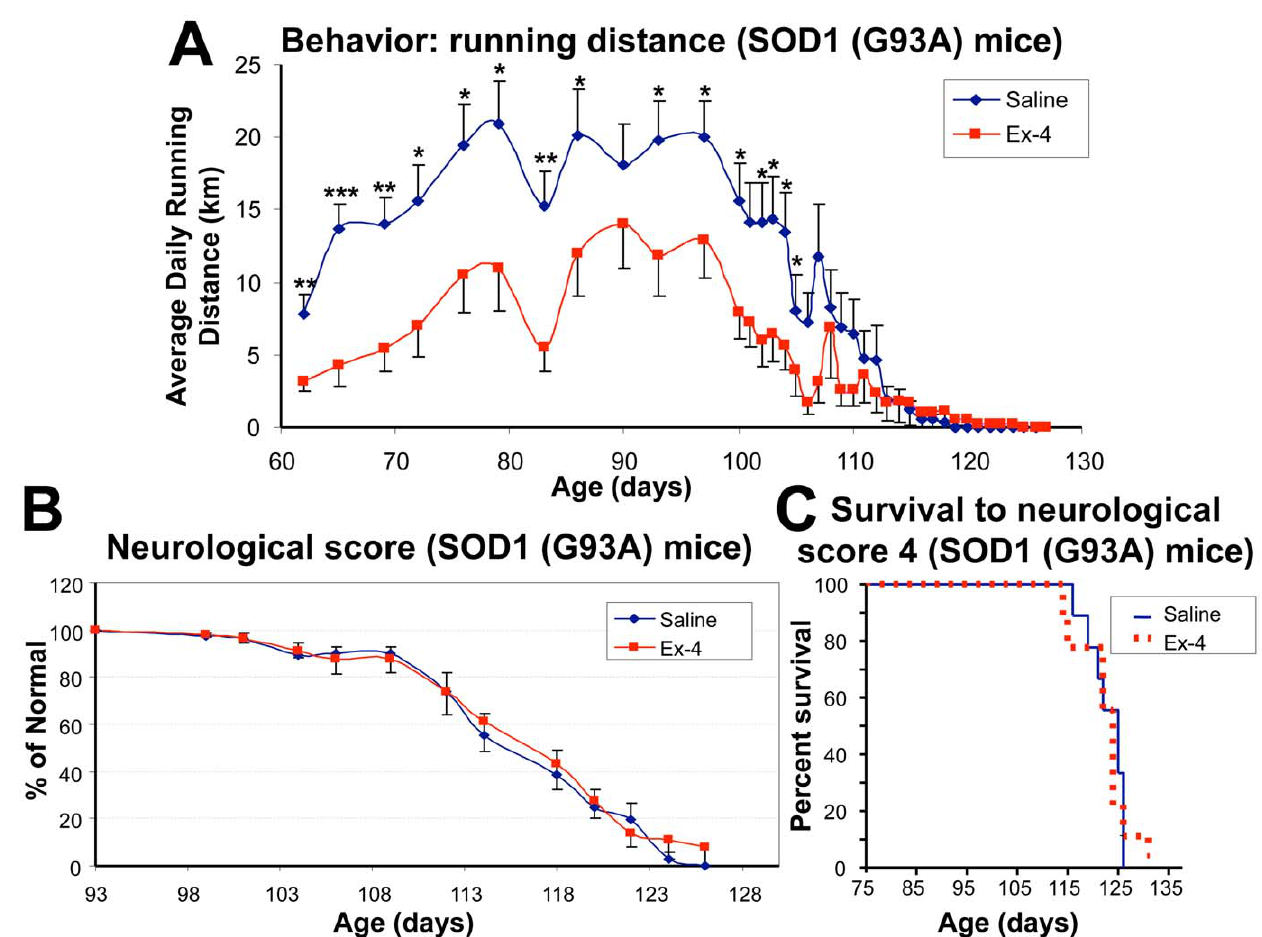
Figure 5. Behavioral effects of exendin-4 action in SOD1 (G93A) mice. ( A ) Comparison of average daily running distances of vehicle-treated and Ex-4-treated SOD1 (G93A) mice. During a presymptomatic stage (approximately 62–95 days of age), Ex-4 treatment significantly reduced